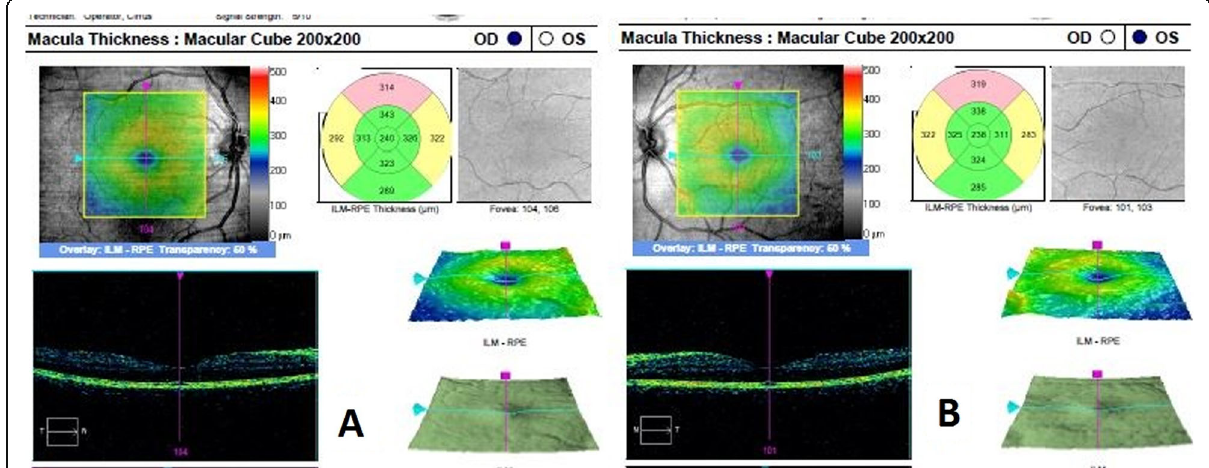
Fig. 2 Optical coherence tomography of the macula, Infra-red fundus images and macular thickness map images of both eyes ( a and b ) are